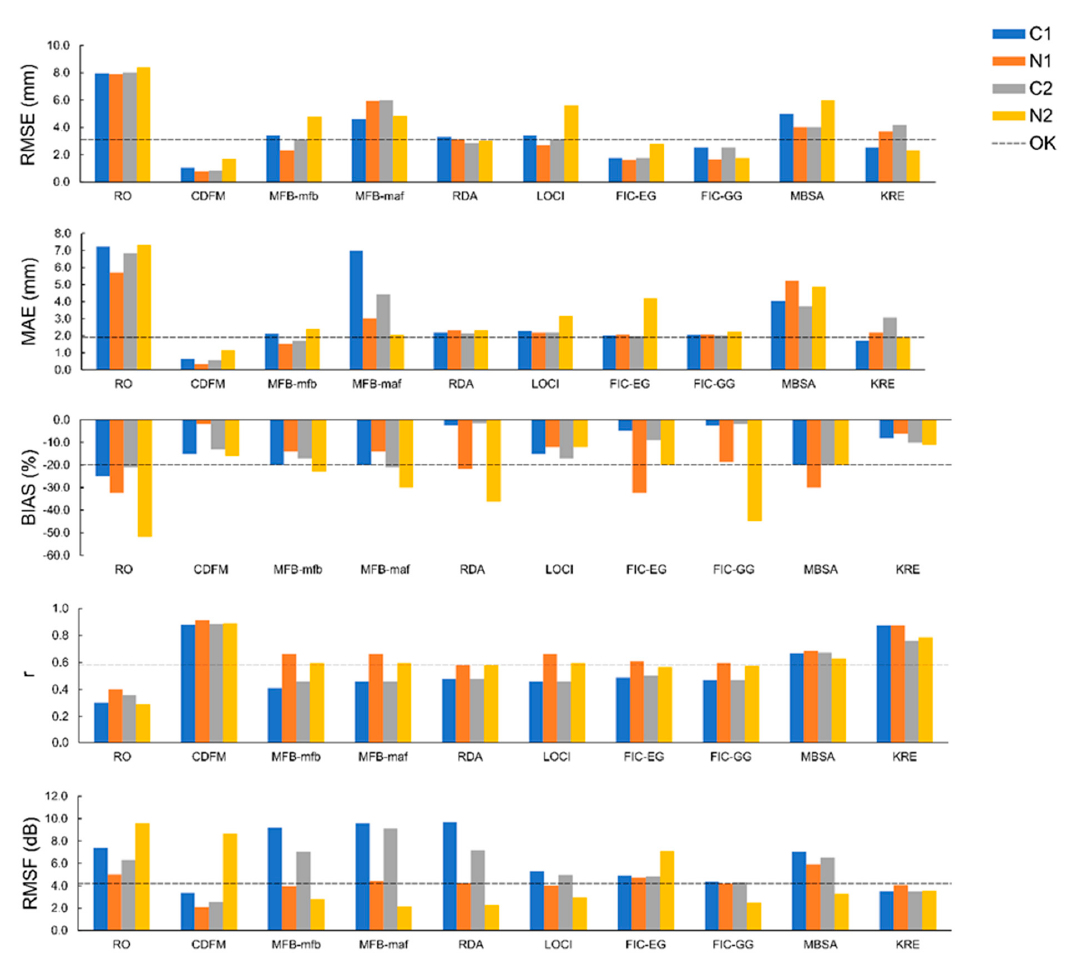
Figure 3. RMSE (mm), MAE (mm), BIAS (%), correlation (r), and RMSF of all radar-gauge merging methods.